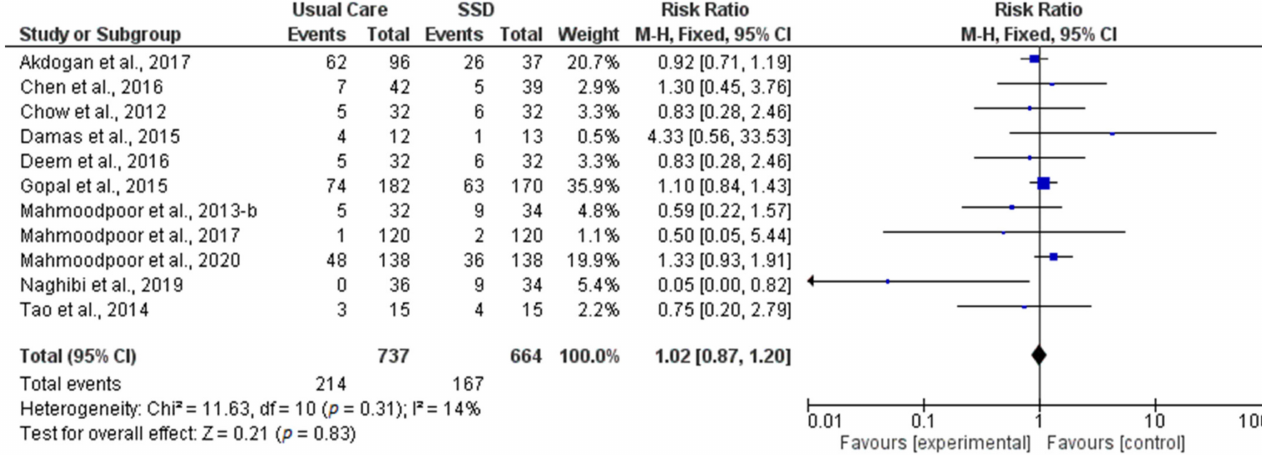
Figure 5. Mortality in the usual care group vs. the SSD